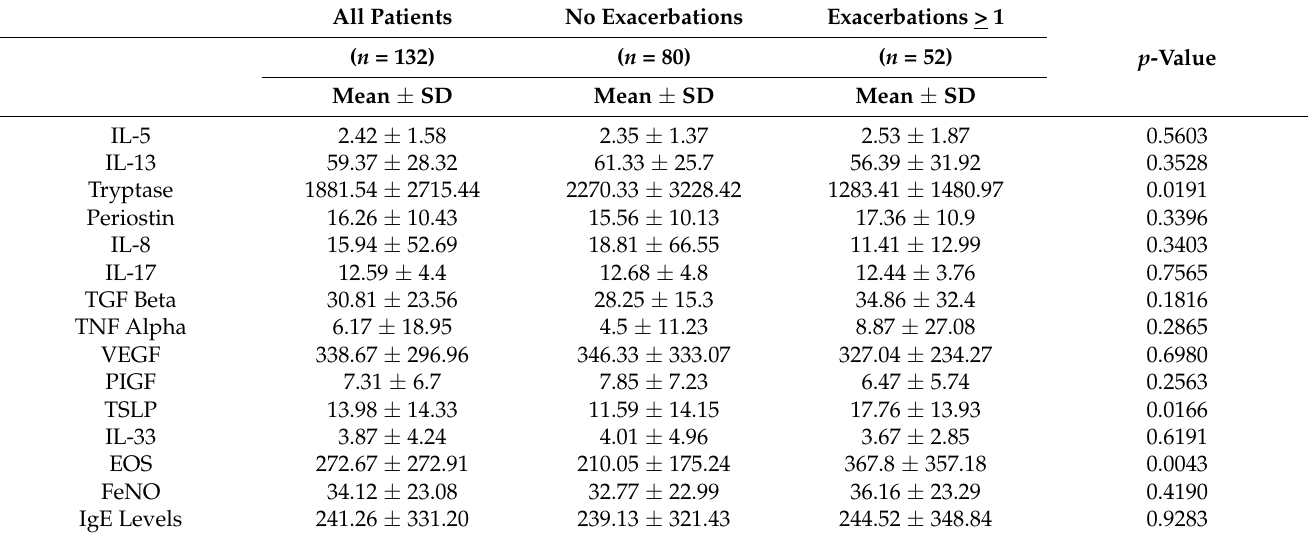
Table 2. Biomarkers of severe asthma patients.